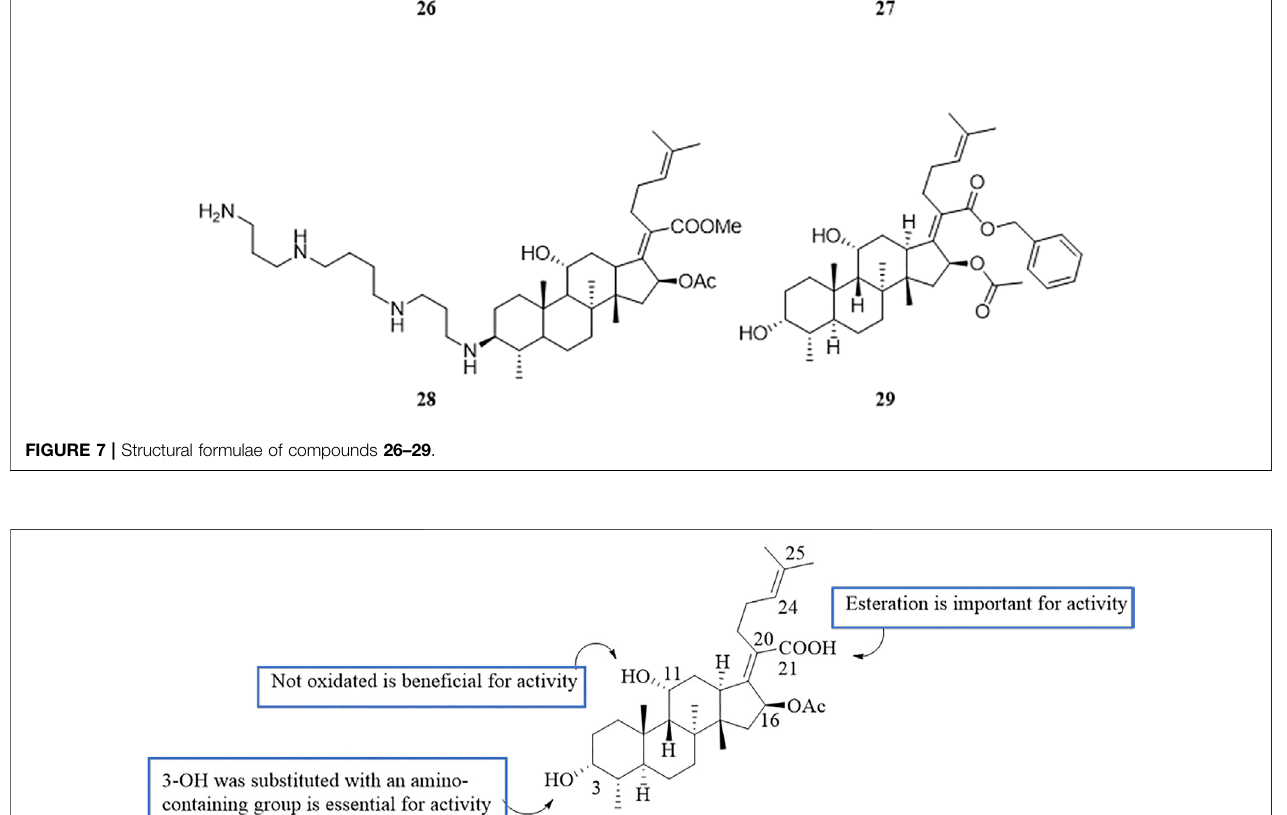
FIGURE 8 | SAR of the antitumor activity of